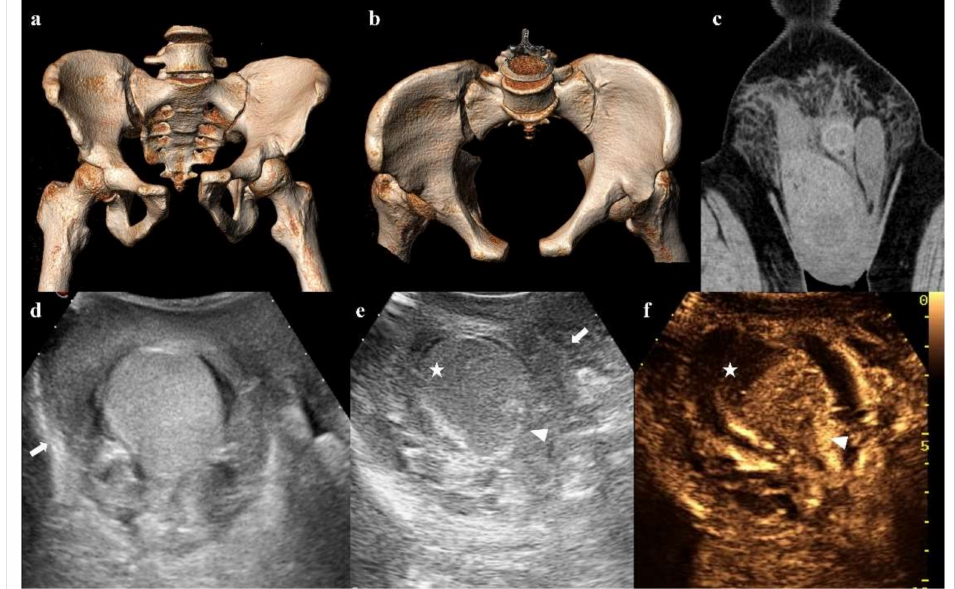
Figure 14. Three-dimensional volume-rendering CT reconstructions in AP and inlet views show an anterior–posterior compression fracture ( a , b ). Coronal CT image shows hematoma in the right inguinoscrotal region ( c ). Ultrasound shows an inhomogeneous hematoma on the extra-albuginea side (arrow in ( d , e )) and a hypoechoic area in the upper part of the testis (star in ( e )). Contrast- enhanced ultrasonography (CEUS) image clearly shows that the hypoechoic area is avascularized, as a hematoma (star in ( f )). Ultrasound and CEUS also show the irregularity of the testicular contour (arrowhead in ( e , f )). These findings are suggestive of testicular